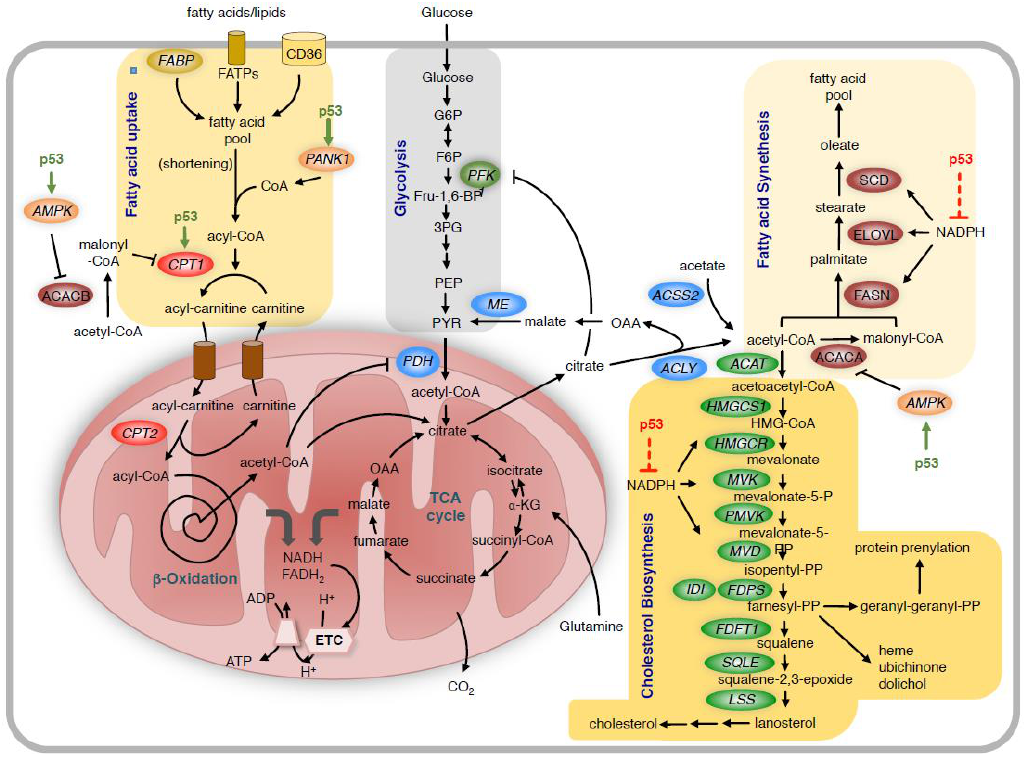
Figure 2. Regulation of lipid metabolism by p53.